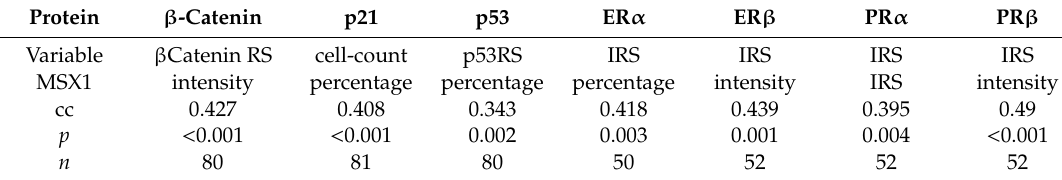
Table 2. Positive correlations between MSX1 and formerly investigated